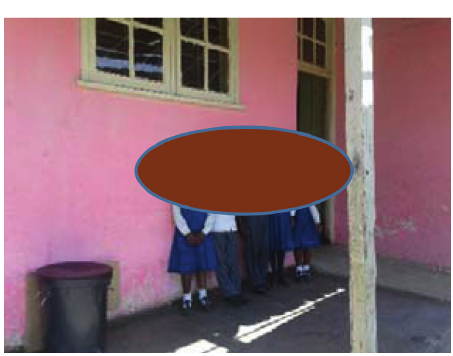
Figure 9: Home for orphaned learners: site one.